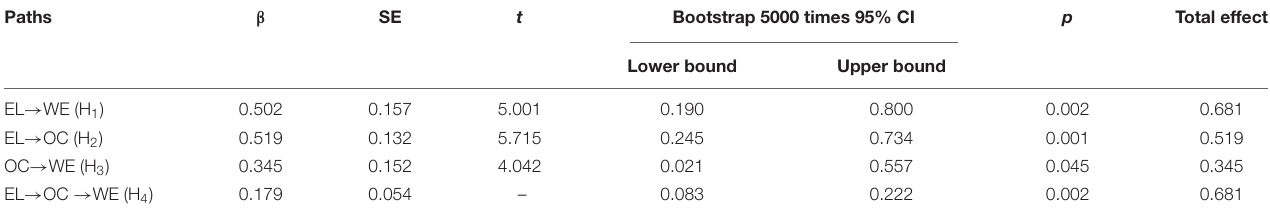
TABLE 3 | Standardized direct, indirect, and total effects.